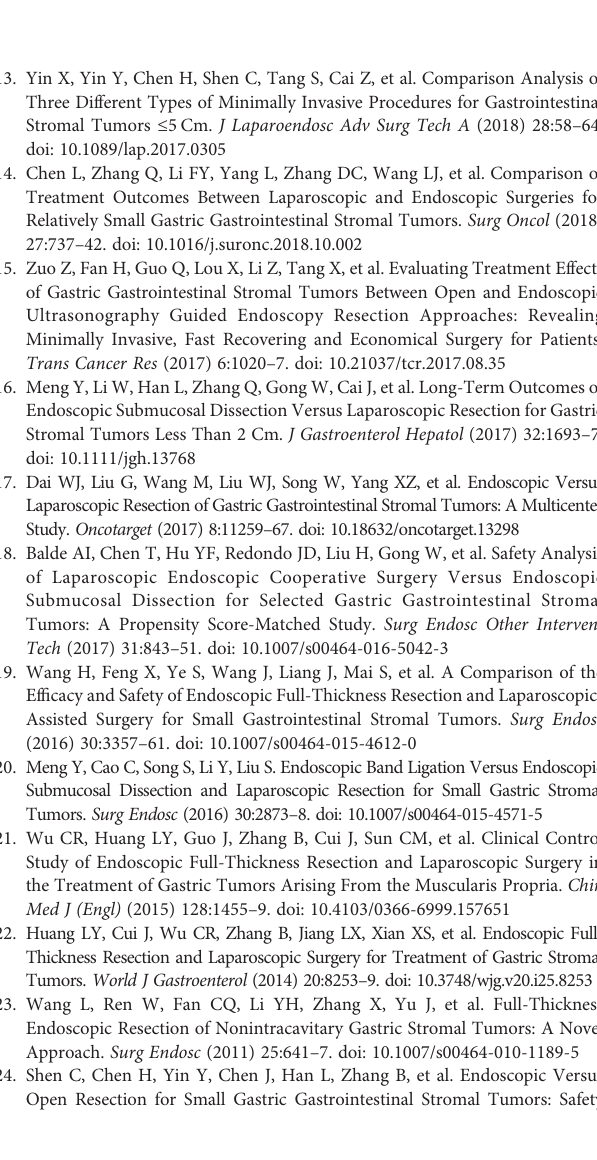
Supplementary Figure 1 | Plots of trace, density, and Brooks – Gelman – Rubin for the network meta-analysis. Supplementary Figure 2 | Plots of trace, density, and Brooks – Gelman – Rubin for the subgroup analysis (tumor size <2 cm). Supplementary Figure 3 | Sensitivity